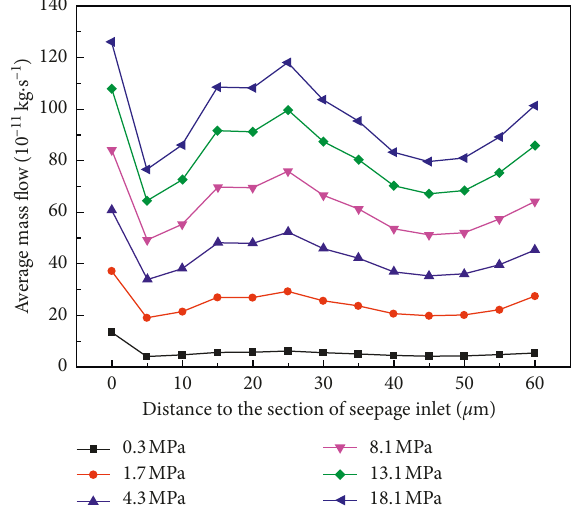
Figure 18: Variations of average seepage mass flow with seepage length under different inlet pressures.